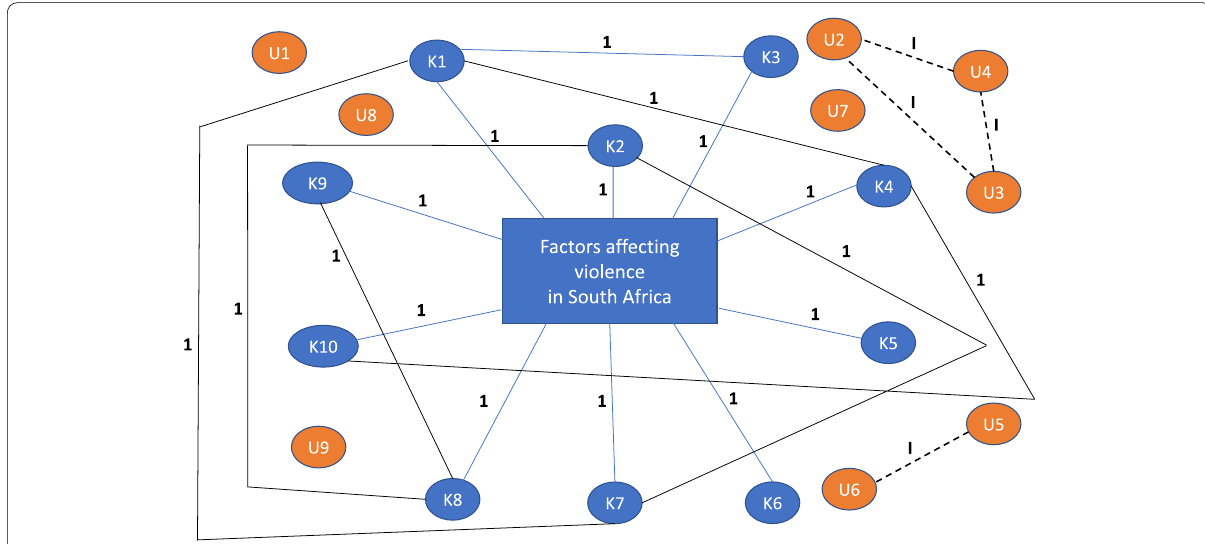
Fig. 6 Fuzzy Cognitive Map based on determinate